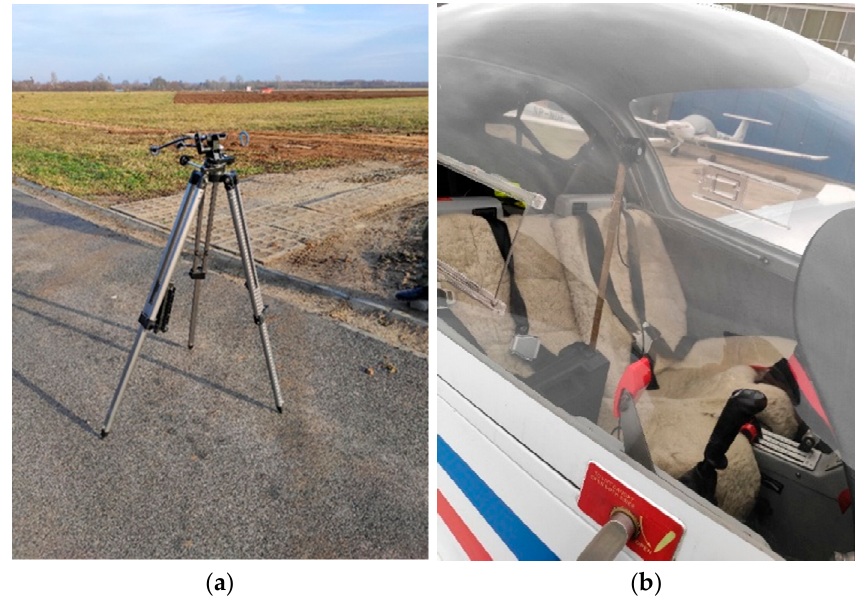
Figure 3. Telescopic tripod with a laser ( a ) and placement of the photometric sensor head in the aircraft cockpit ( b ).